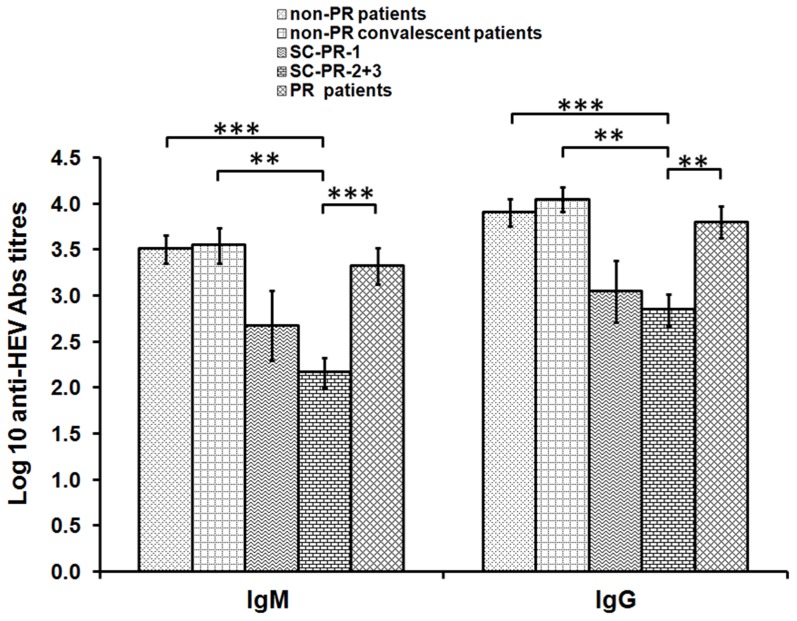
Bar diagram depicting IgM and IgG-anti-HEV titres in different categories of HEV-infected individuals.p values are indicated by stars, ** p<0.05, ***p<0.001.